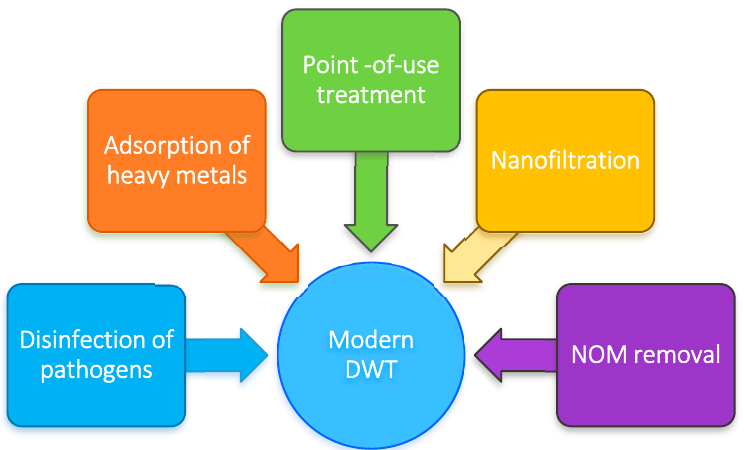
Figure 6. Contribution of NTs on modern drinking water treatment.